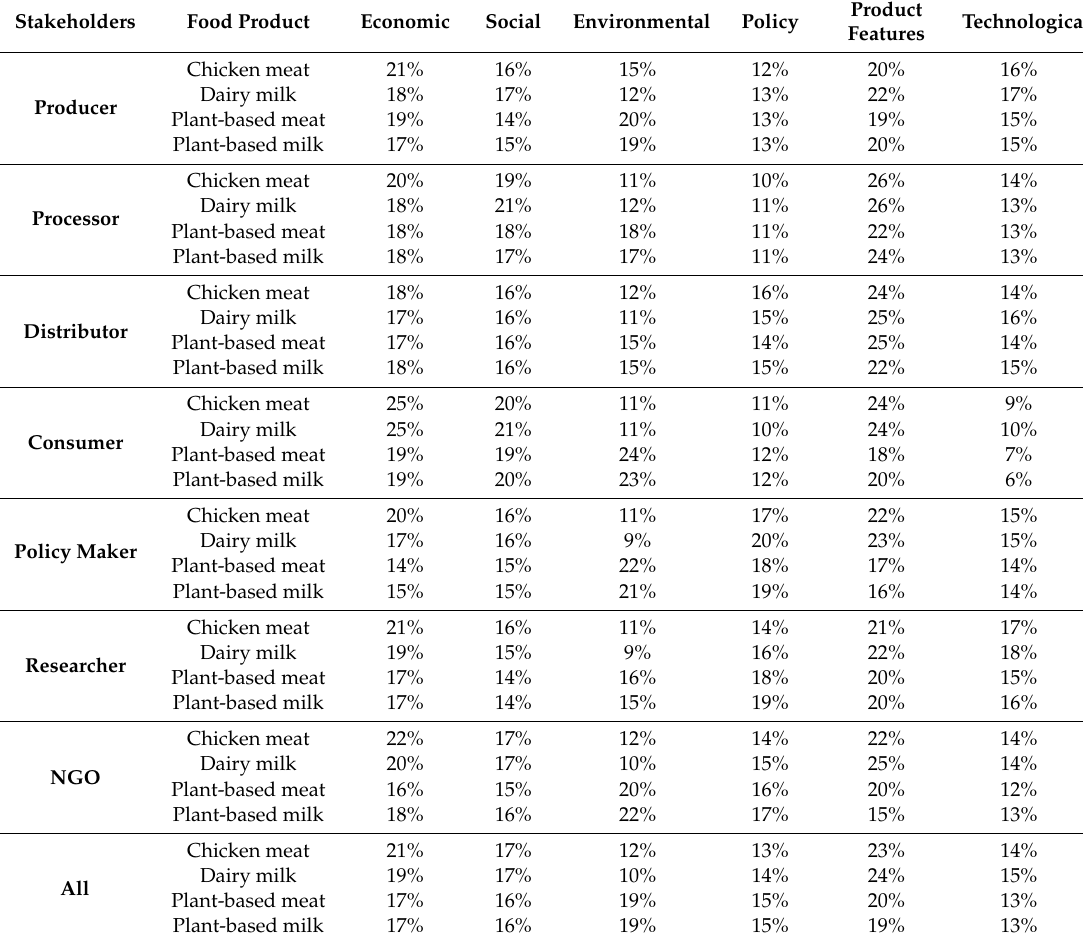
Table A2. Performance of food products under each criterion by stakeholder group (average weight of each criterion